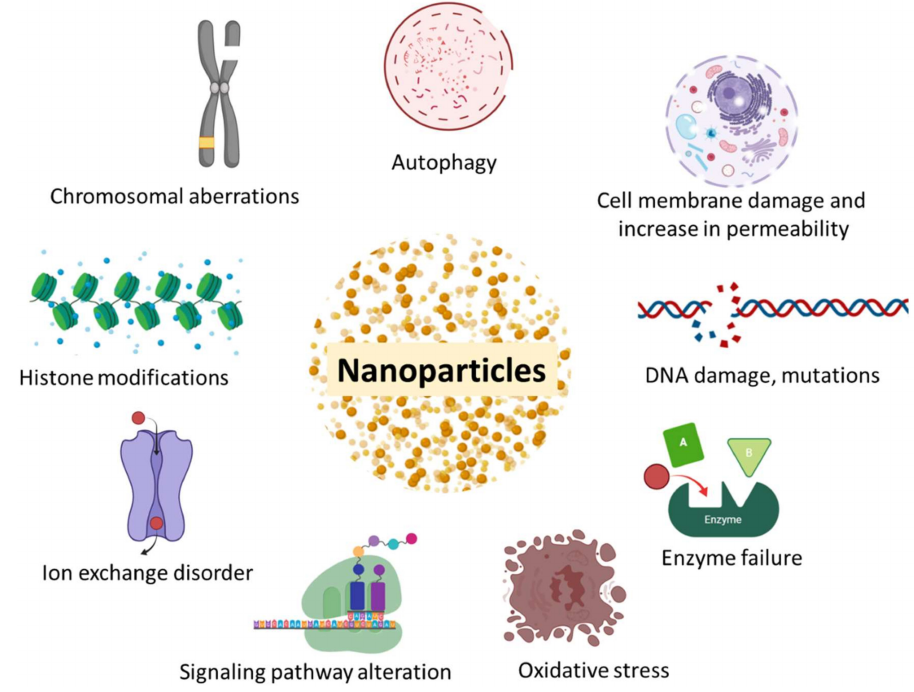
Figure 6. Toxicity associated with